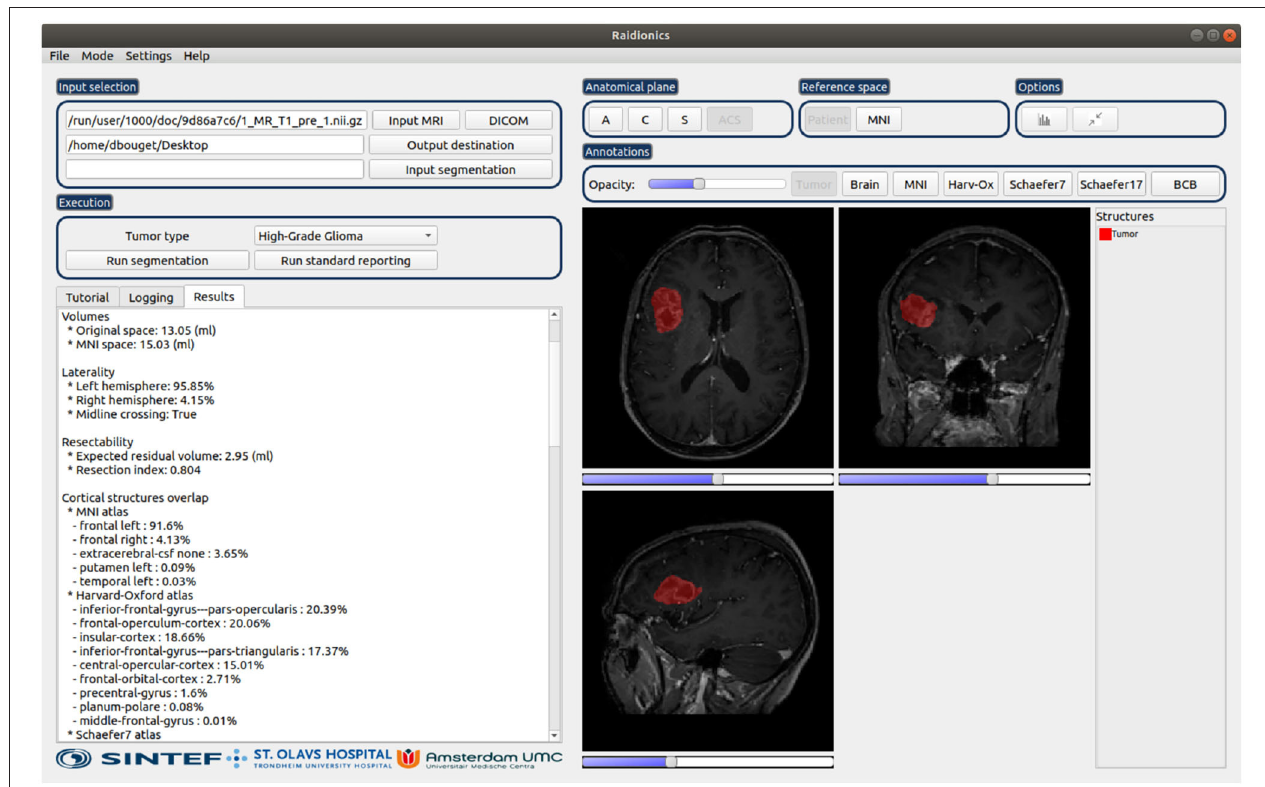
FIGURE 2 | Illustration of the Raidionics software after generating the standardized report for a patient suffering from glioblastoma. The left side presents the tumor characteristics belonging to the report, whereas the right side offers a simplistic view.